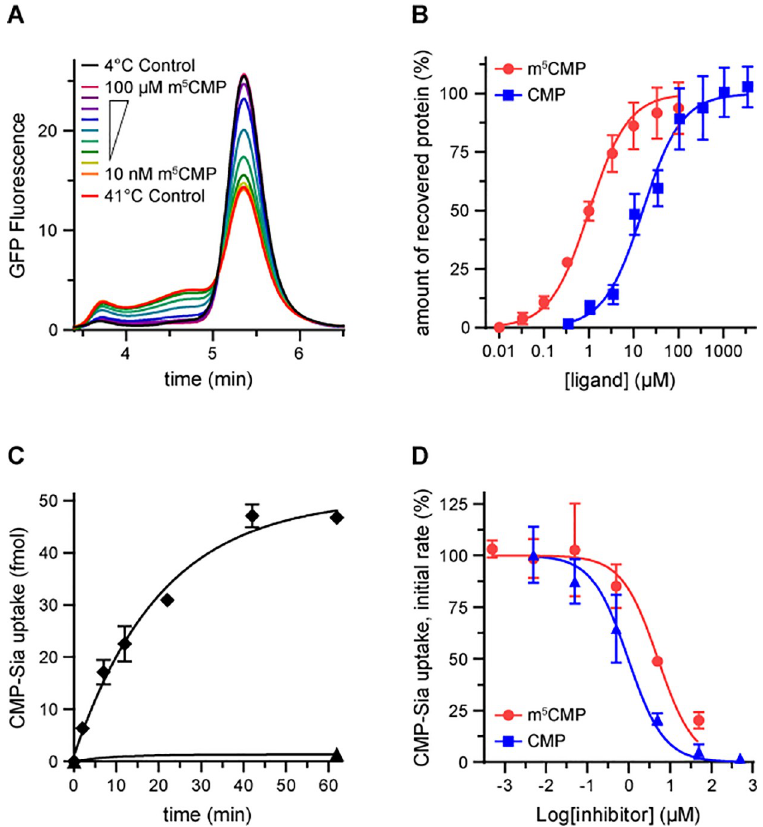
Fig 4. Binding constants and CMP-Sia transport inhibition for m 5 CMP and CMP. A) Aliquots of DDM-solubilized GFP-tagged CST protein were either kept at 4˚C (black trace) or heated to 41˚C, either alone (red trace) or in the presence of the indicated concentration of m 5 CMP for 15 min. The samples were clarified and then run on a gel filtration column with fluorescence detection. The sample eluting at ~5.4 min represents natively-folded protein. B) The peak heights from the traces in panel A were normalized to the highest (4˚C with no ligand added) and lowest (41˚C with no ligand added) peak height and are plotted against ligand concentration to determine binding constants. The plotted values represent the mean ± SEM, n = 2. C) Intact Sf9 insect cells expressing CST (diamonds) or uninfected cells (triangles) were incubated with 30nM [ 3 H]CMP-Sia for the indicated amount of time at room temperature. The plotted values represent the mean ± SEM, n = 2. D) Intact Sf9 insect cells expressing CST (diamonds) were incubated with 30 nM [ 3 H]CMP-Sia and the indicated concentration of inhibitor for 5 min at room temperature. The initial rate of uptake is plotted against inhibitor concentration in order to determine inhibition constants. The plotted values represent the mean ± SEM, n = 4.